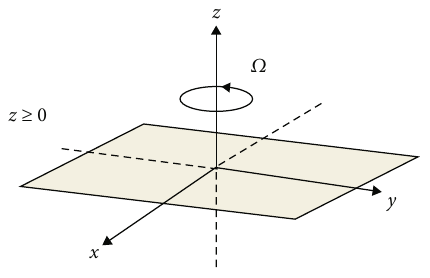
Figure 1: Graphical representation of fl uid fl